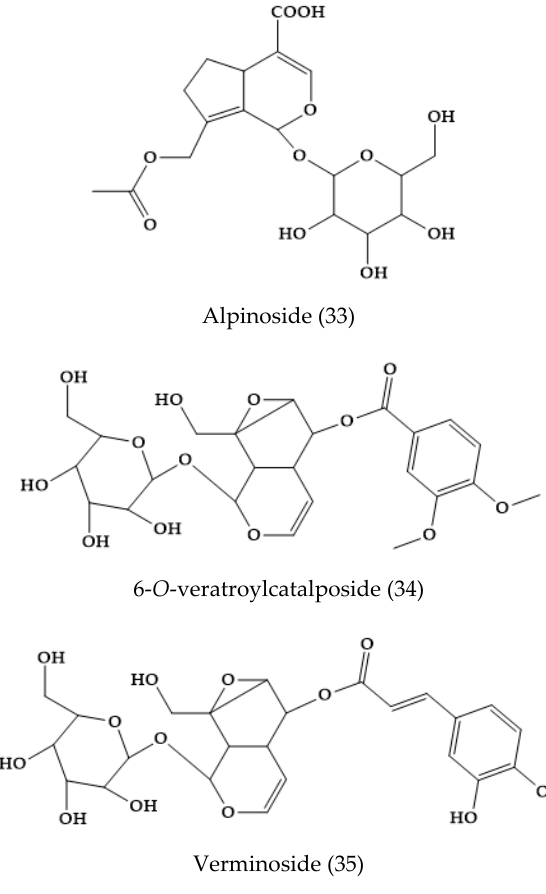
Figure 6. Phytoconstituents from Veronica cymbalaria .